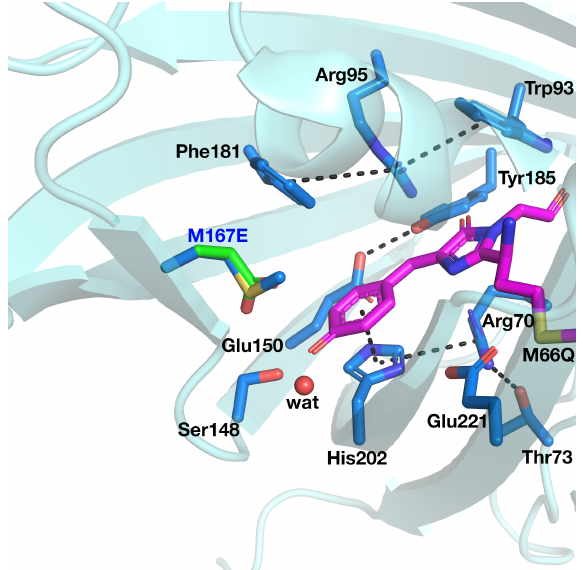
Figure 3. Active site of the psamFP488 homologous zFP538-K66M, with the M167E mutation high- lighted. In psamFP488, Met66 is also mutated (Gln66). The chromophore and surrounding residues are shown in sticks representation, and the protein is shown as a cartoon representation. Hydrogen bonds, salt bridges, and π -stacking interactions involving residues surrounding the chromophore are highlighted as black dashed lines. All hydrogen atoms are hidden for